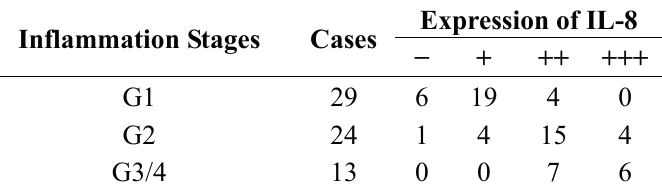
Table 2. The relationship between the expression of IL-8 and the degree of liver inflammation, r = 0.660, p < 0.001.